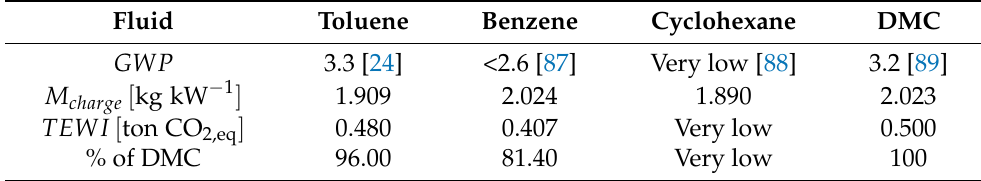
Table 9. TEWI value for the promising fluids.